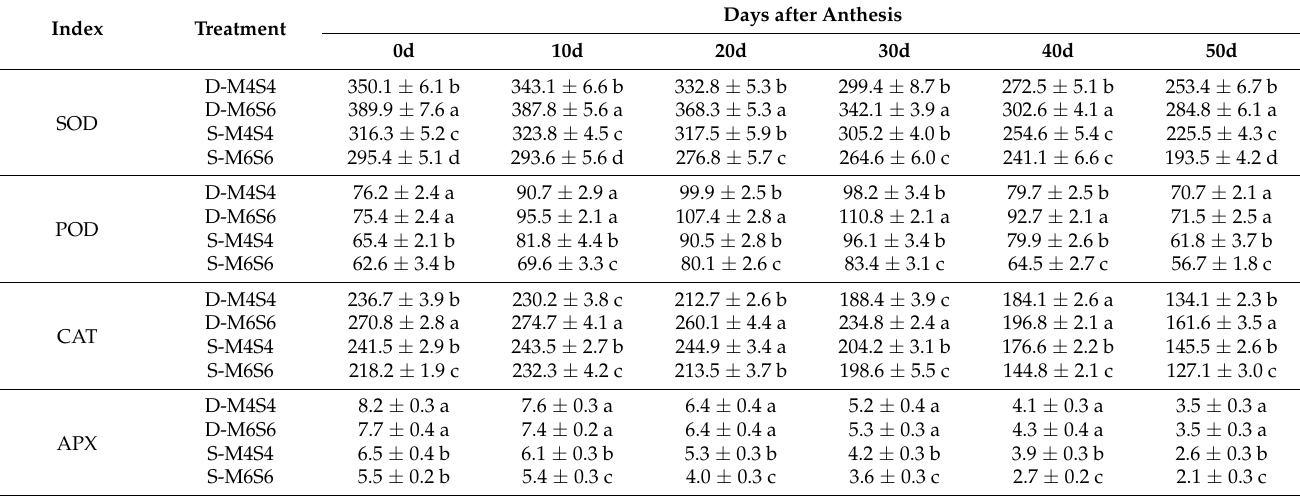
Table 4. Effect of planting pattern and row spacing on the antioxidant enzyme activity of maize ear leaves.